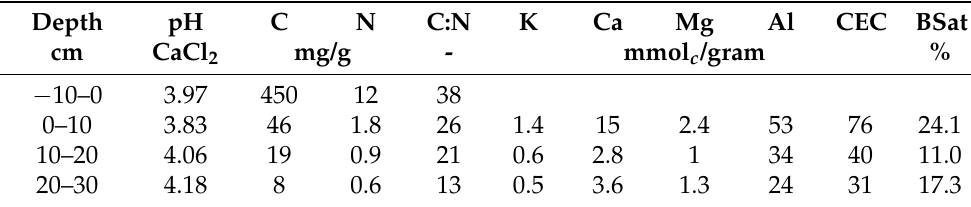
Table 1. Chemical soil characterization. K, Ca, Mg, Al—exchangeable cations (unbuffered BaCl 2 extract), CEC—cation exchange capacity, BSat—base saturation.